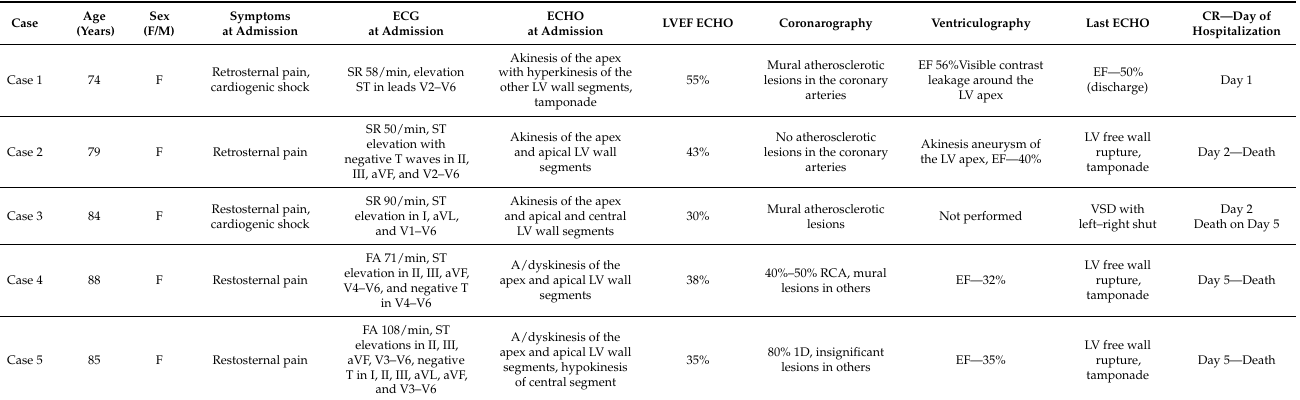
Table 3. Clinical characteristics and imaging of the five